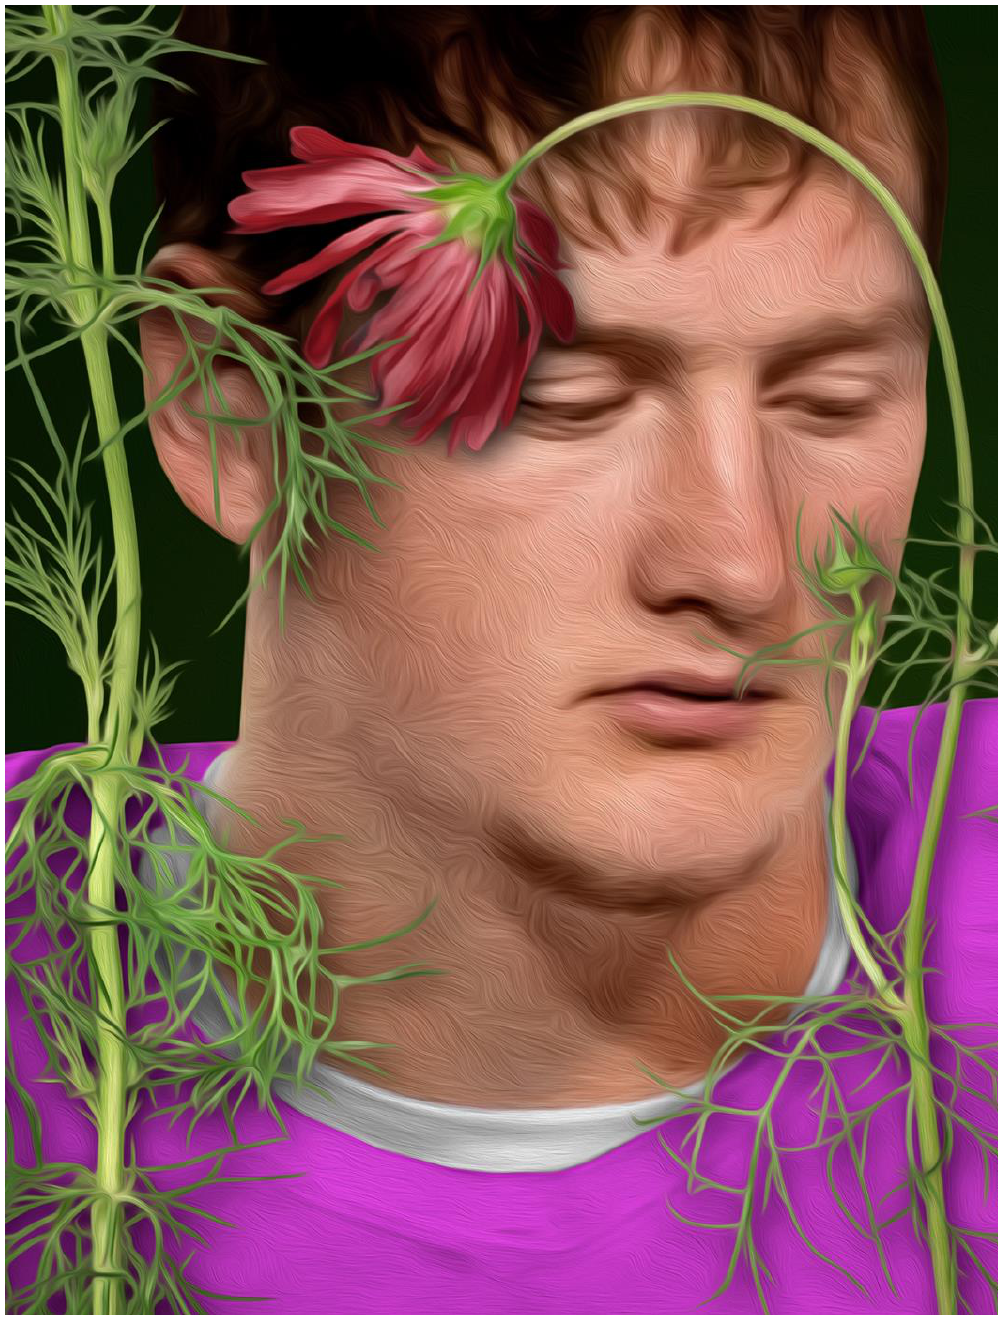
Figure 1 Nick Simko, Football (1) , 2018, Digital Composite Photograph, Inkjet Print on Paper, 31 x 31 ½